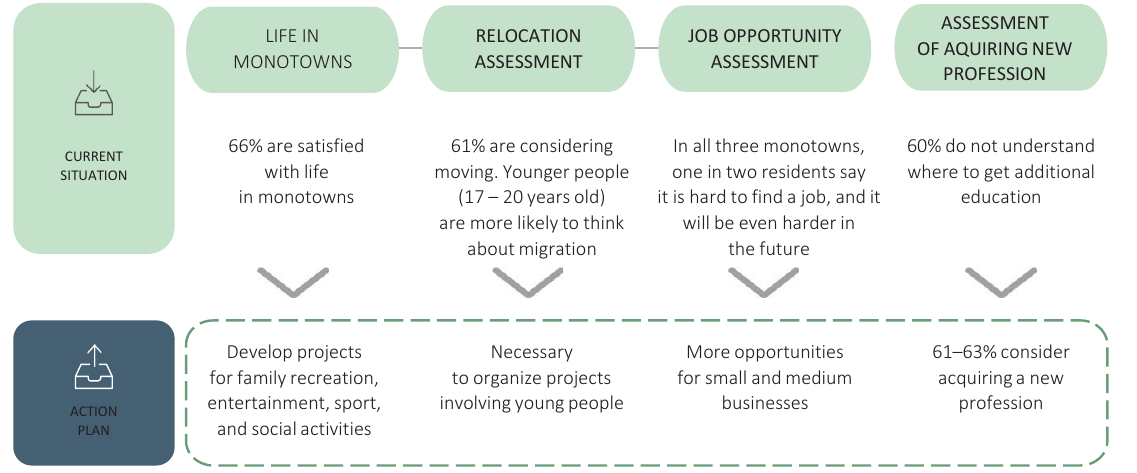
Figure 1. Research results and action plan for selection of regional development projects